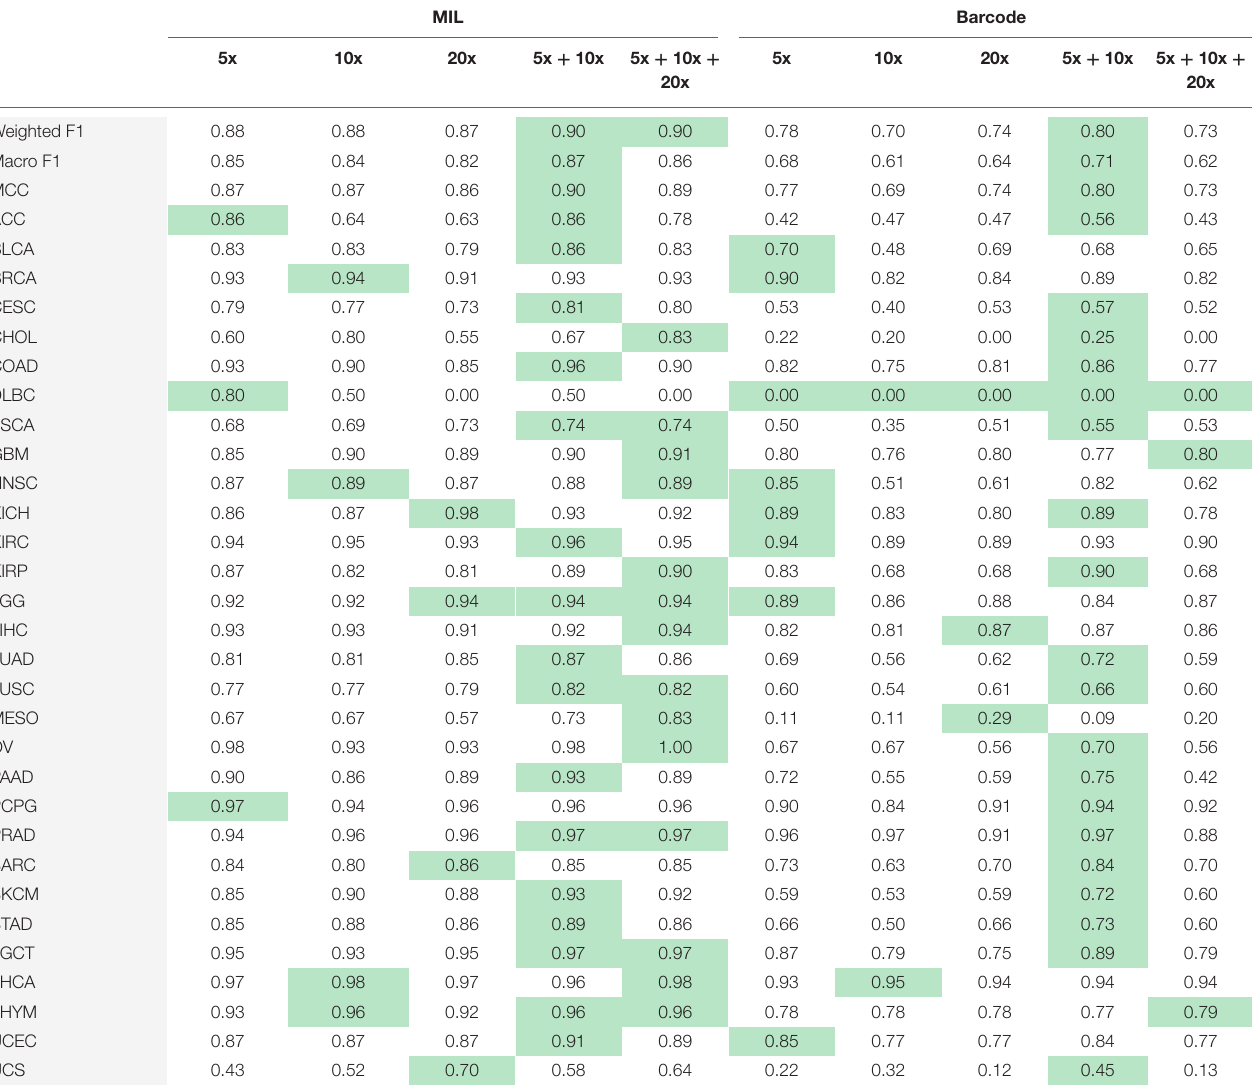
The results are obtained by training the model on the entire set of slides, after reserving a 20% split for testing. The value of the best performing magnification (or combination thereof) is highlighted in green. The top 3 rows show the aggregated classification results: weighted F1, macro F1 and MCC scores for the overall classification across all different tumor types on the test